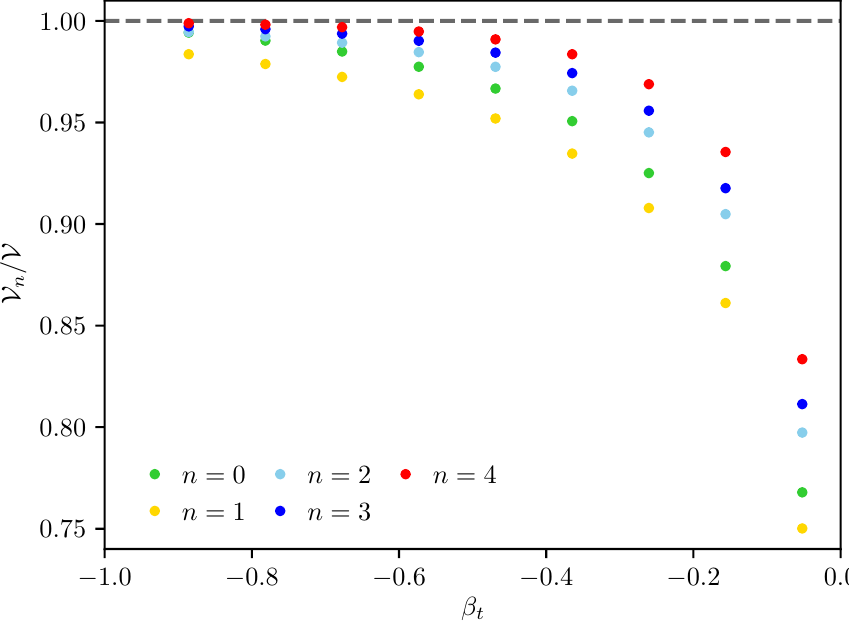
between production t